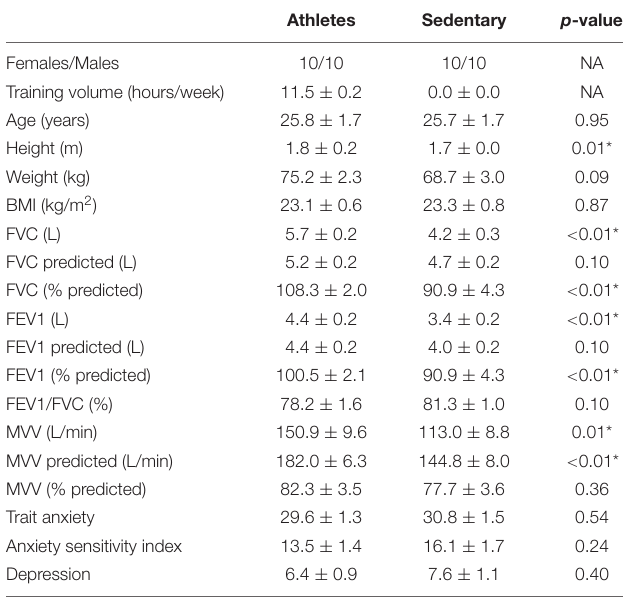
TABLE 1 | Participant